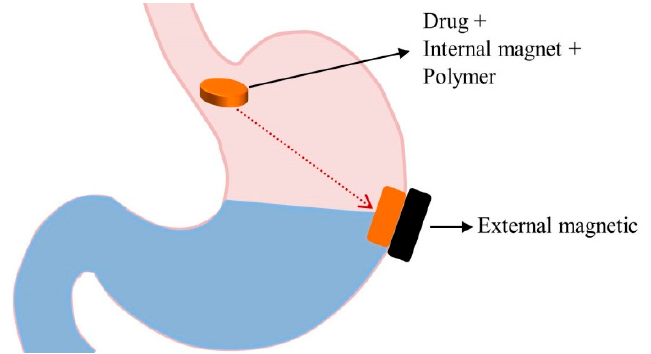
Figure 6. GRDDS based on magnetic systems.